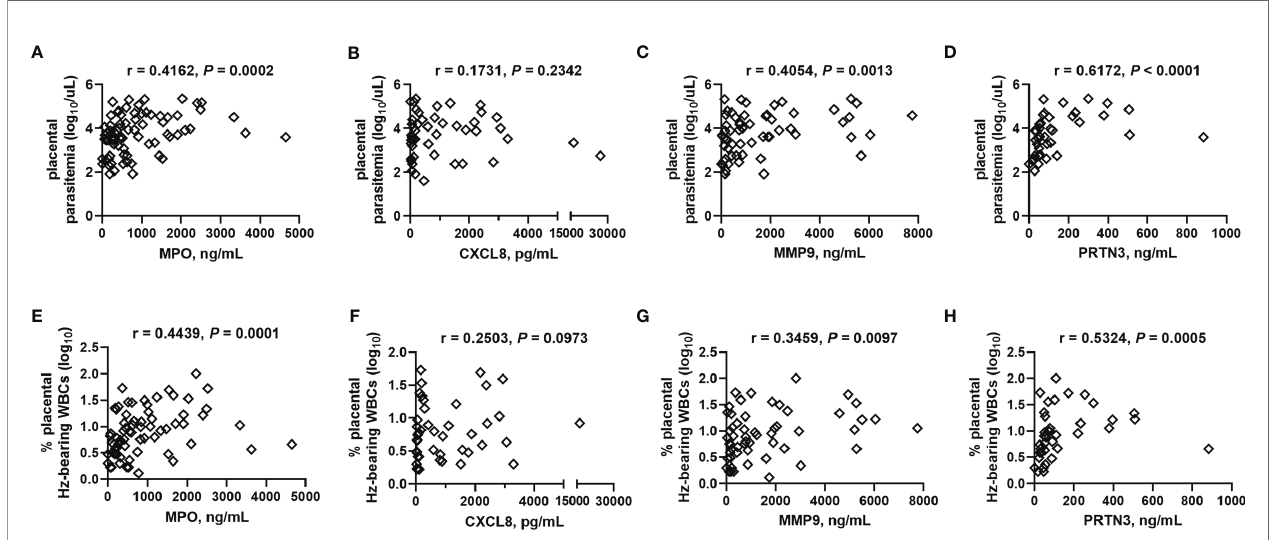
FIGURE 7 | Placental blood MPO, MMP9, and PRTN3 levels positively correlate with placental parasite density and hemozoin-bearing white blood cells. (A, E) MPO, (B, F) CXCL8, (C, G) MMP9, and (D, H) PRTN3 levels measured by bead array in plasma are collectively analyzed by Spearman ’ s correlation test with (A – D) thick smear placental parasite density (log transformed) and (E – H) percent placental WBCs bearing engulfed hemozoin (log transformed). (A) , n = 77; (B) , n = 49; (C) , n = 61; (D) , n = 43; (E) , n = 73; (F) , n = 47; (G) , n = 57; (H) , n =